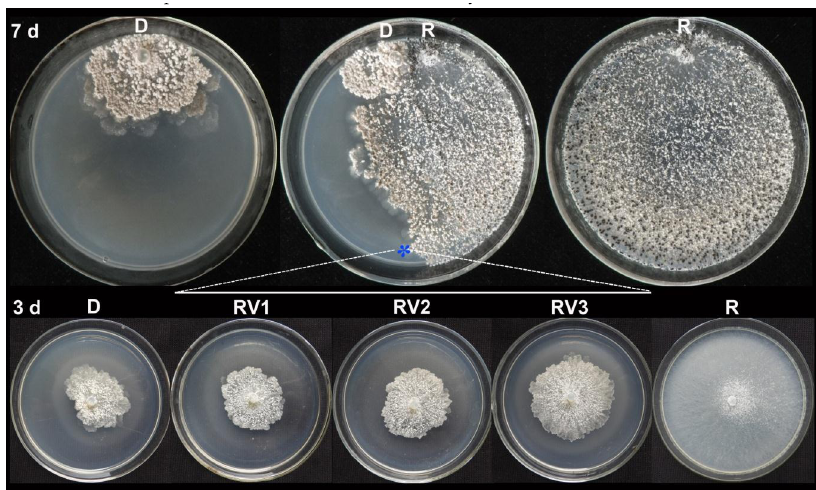
Figure 3. Horizontal transmission of SmEV1 from the donor strain LC22 (D, donor; SmEV1 + ) to the recipient strain LC41 (R, recipient; SmEV1 − ) through hyphal contact in a pair culture, with comparison of the strains in single cultures. Top row: two single cultures of the donor strain LC22 and the recipient strain LC41, respectively, and a pair culture of LC22/LC41 (D/R) on PDA (20 °C, seven days). “*” in the pair-culture indicates the area where a mycelial agar plug was removed for generating a derivative of the recipient strain designated as RV. Bottom row, PDA cultures (20 °C, three days) of the donor strain LC22 (D, SmEV1 + ) and the recipient strain LC41 (R, SmEV1 − ), and three derivative isolates generated from the recipient strain LC41 in the pair cultures of LC22/LC41